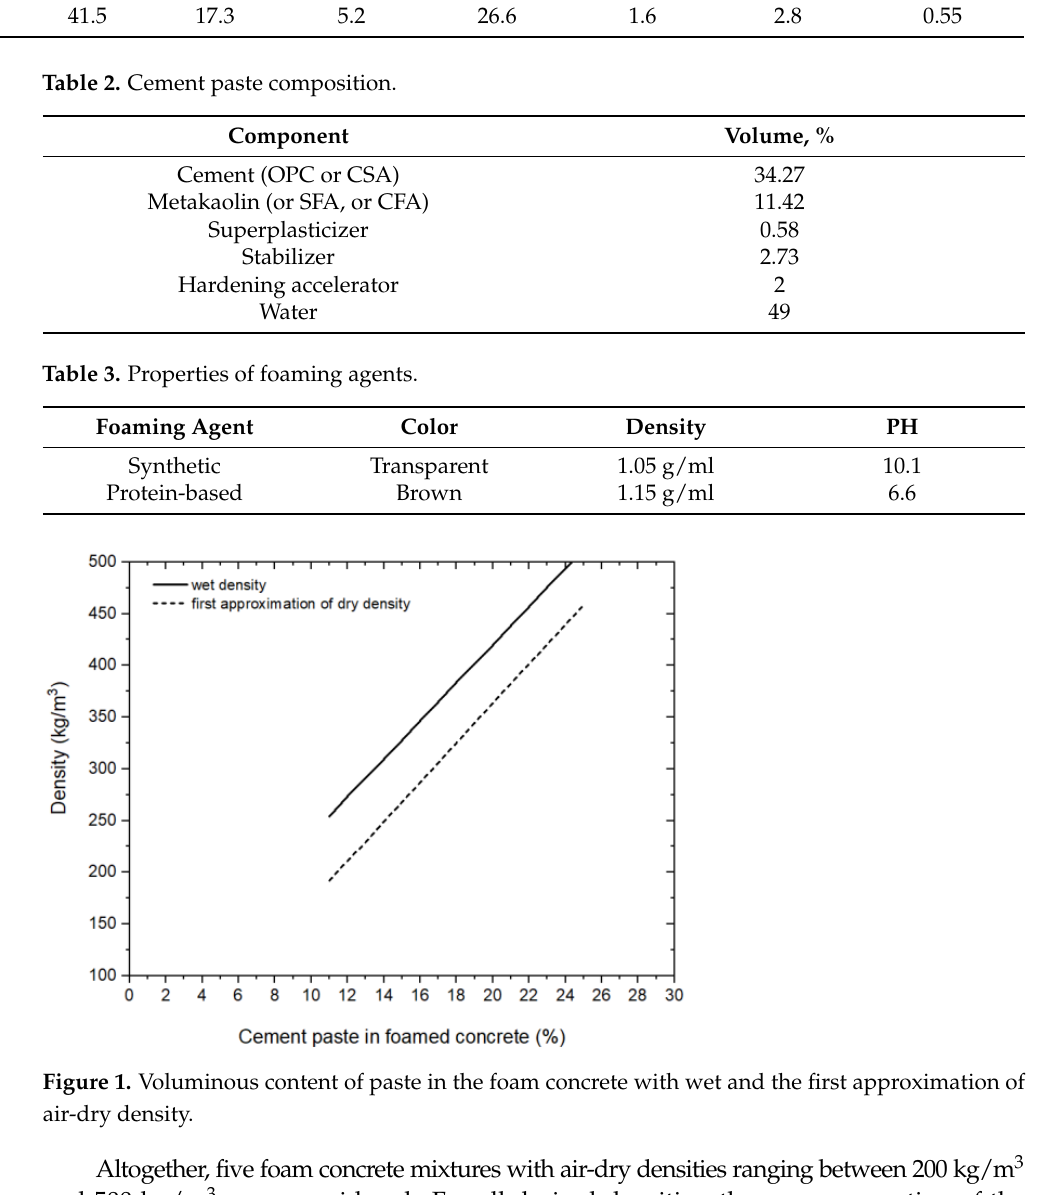
Table 2. Cement paste composition.